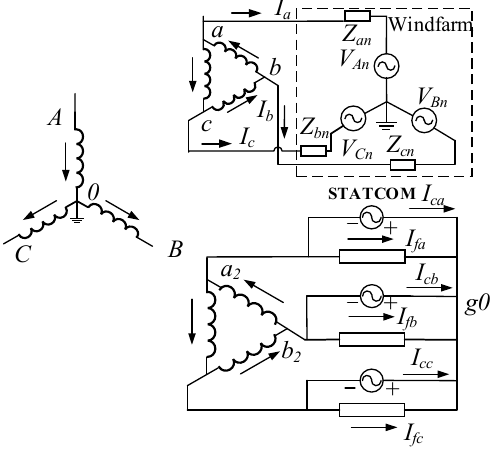
Figure 8. The current distribution of the new grid ‐ connected transformer.